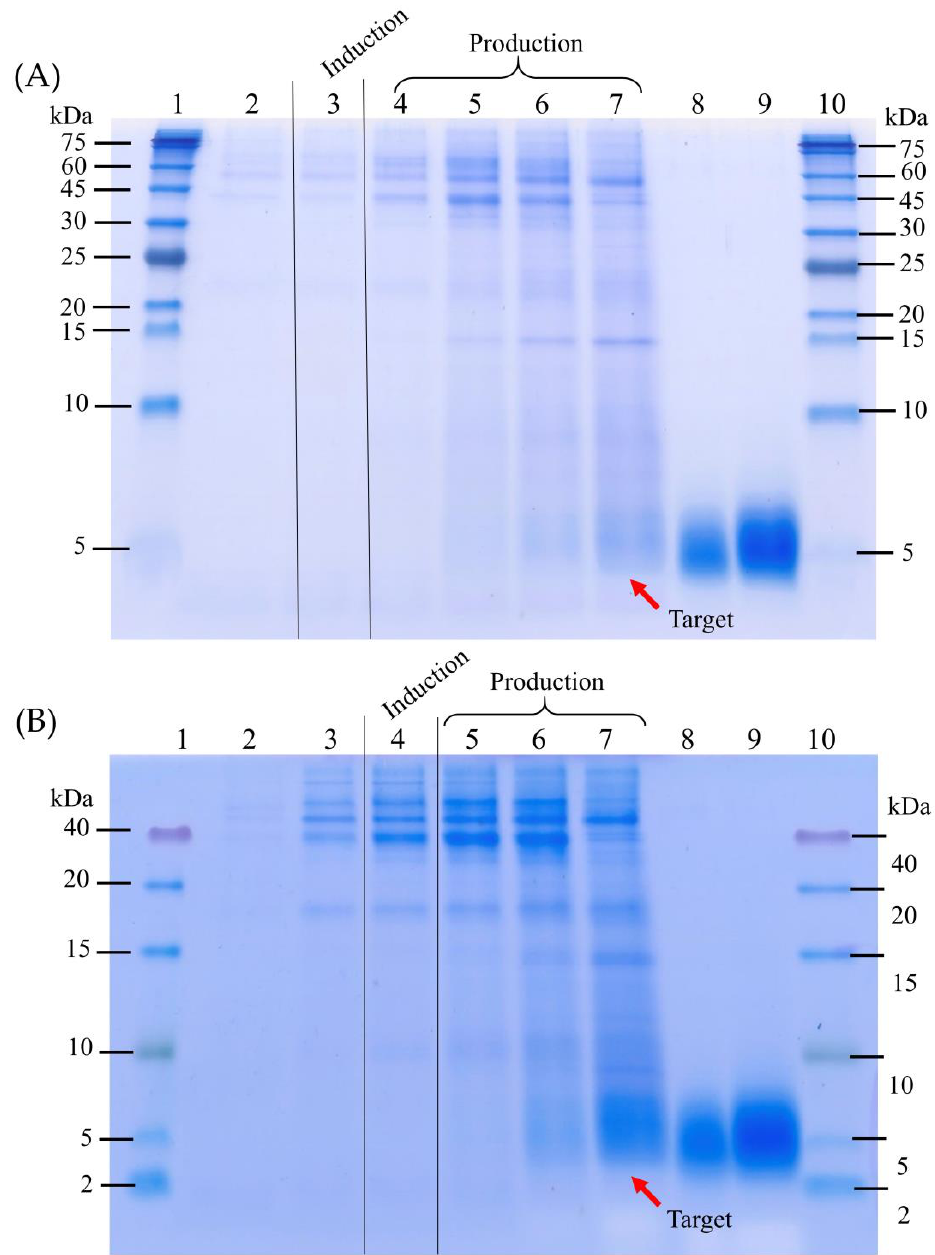
Figure 2. Tricine SDS-PAGE analysis of the culture supernatant from the expression of the CAP2 candidate utilizing the four-stage fermentation process ( A ) and the improved fermentation process ( B ). ( A ) The samples in lanes 1 and 10 were protein molecular weight markers; lane 2 was the finished glycerol fed-batch stage; lane 3 was the finished methanol induction stage; lanes 4, 5, 6, and 7 were 16, 40, 50, and 65 h of the production stage, respectively; lanes 8 and 9 were 1.76 and 3.52 g/L of the CAP2, respectively. ( B ) The samples in lanes 1 and 10 were protein molecular weight markers; lane 2 was the finished glycerol batch stage; lane 3 was the finished glycerol fed-batch stage; lane 4 was the finished methanol induction stage; lanes 5, 6, and 7 were 24, 48, and 72 h of the production stage, respectively; lanes 8 and 9 were 1.76 and 3.52 g/L of the CAP2, respectively. The arrows represent the target peptide CAP2 ( ≈ 4.1